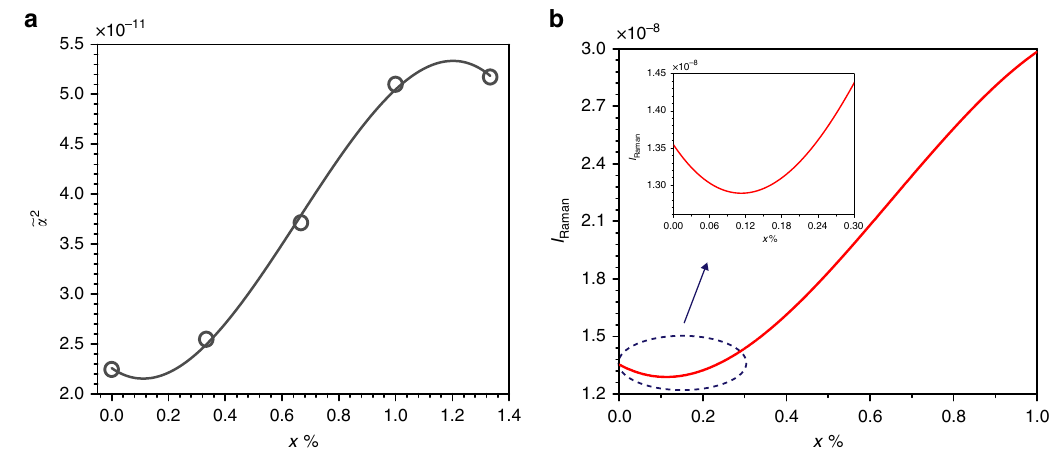
Fig. 5 First principles calculation for TiO 2 . a ~ α 2 vs. x , and the fi tted polynomial curve (red line); b I Raman vs. x for the anatase TiO 2 .